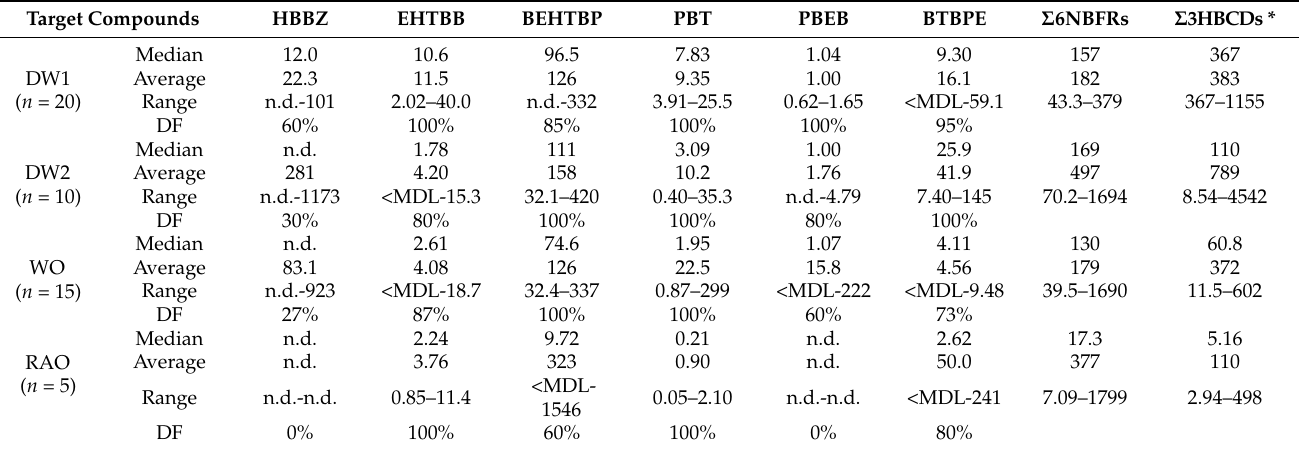
Table 1. Concentrations (ng/g) and detection frequencies (DF, %) of NBFRs and HBCDs in dust samples from e-waste-dismantling